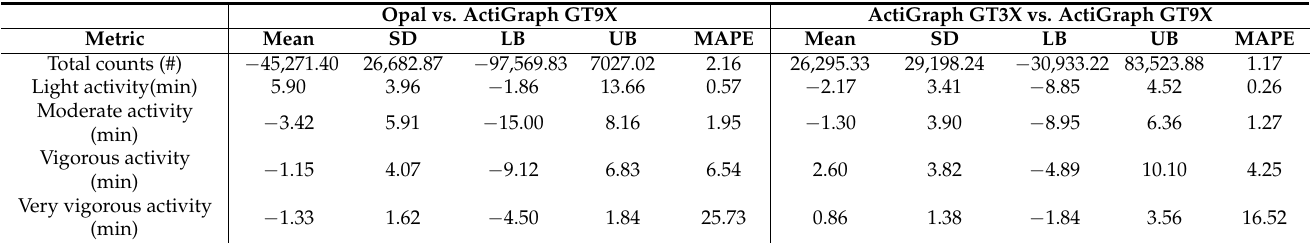
Figure 2. Bland – Altman plots of total counts using FreedsonVM3 algorithm. Table 3. Performance between Opal and Actigraph GT9X, and between Actigraph GT3X and GT9X on activity measures (FreedsonVM3). Opal vs. ActiGraph GT9X ActiGraph GT3X vs. ActiGraph GT9X